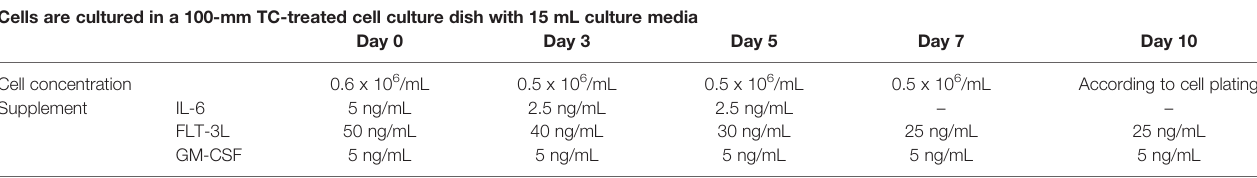
Culture of BMDCs: BMDCs were seeded into a 100-mm TC-treated cell culture dish with 15 mL culture media. Culture media is supplemented with variable concentrations of GM-CSF, FLT-3L and IL-6 on day 0, day 3, day 5, day 7 and day 10 to harvest fully differentiated BMDCs on day 11.